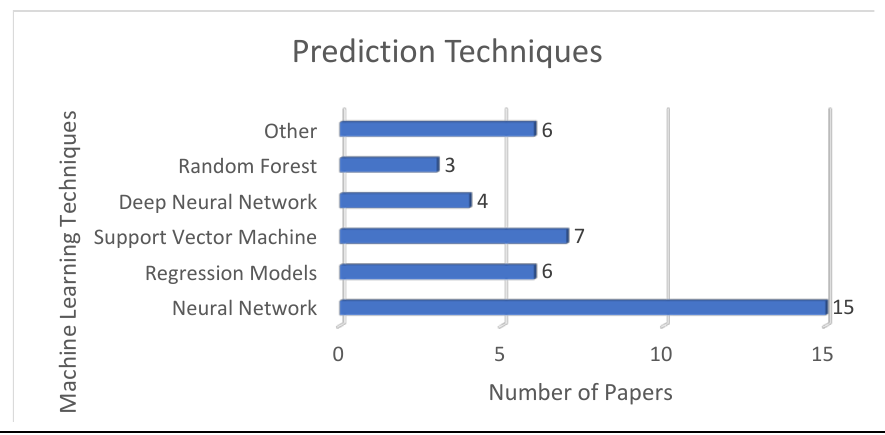
Figure 15. Top prediction techniques identified in our survey.